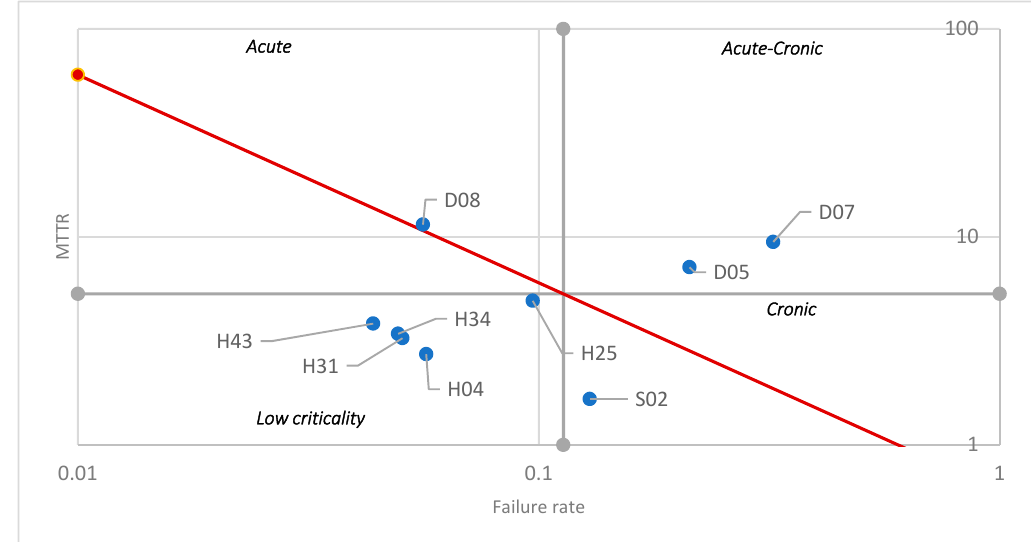
Figure 6. Jack Knife diagram for criticality analysis.